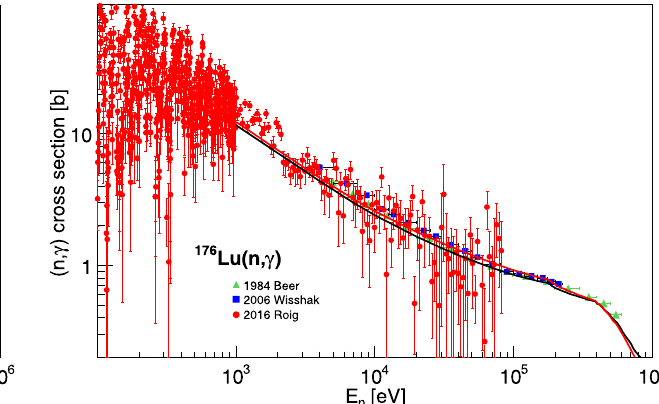
Fig. 10. 176 Lu( n , g ) 177 Lu cross-section as function of the incident neutron energy E . The dotted blue line show the predictions obtained using the default options of the TALYS code for the level density and gamma-ray strength function as well as a normal- ization G norm =3.6. The full black line shows the predictions obtained adding on top of the defaut prescriptions a low energy M1 strength without any normalization ( G norm = 1). Experi- mental data are taken from references [34 – 36].